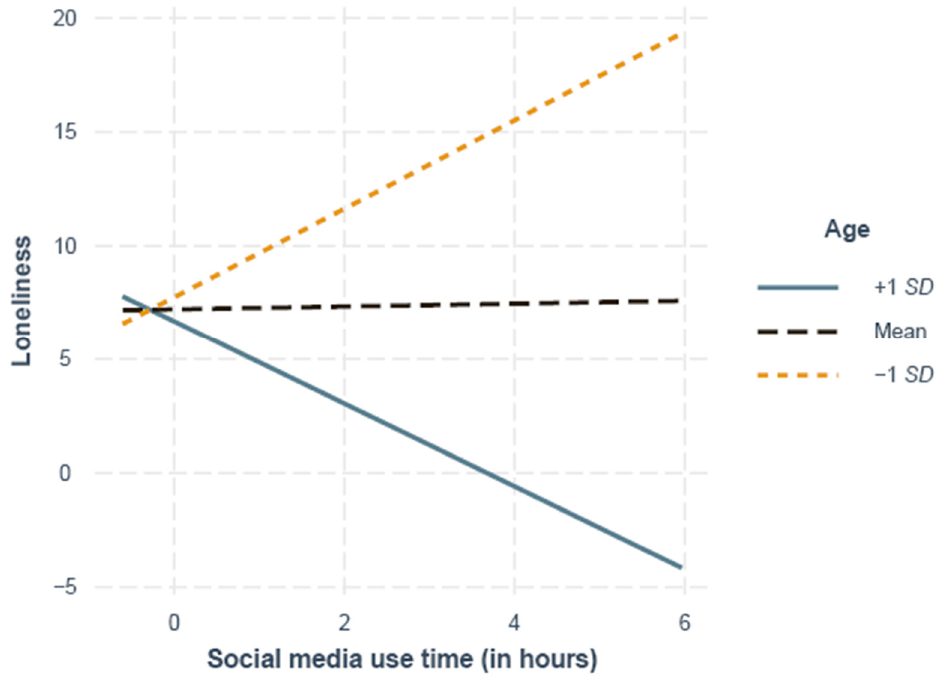
Figure 3. Simple slopes of the social media use time and loneliness at 1 SD above (55 years), 1 SD below (29 years), and the mean age (42 years).